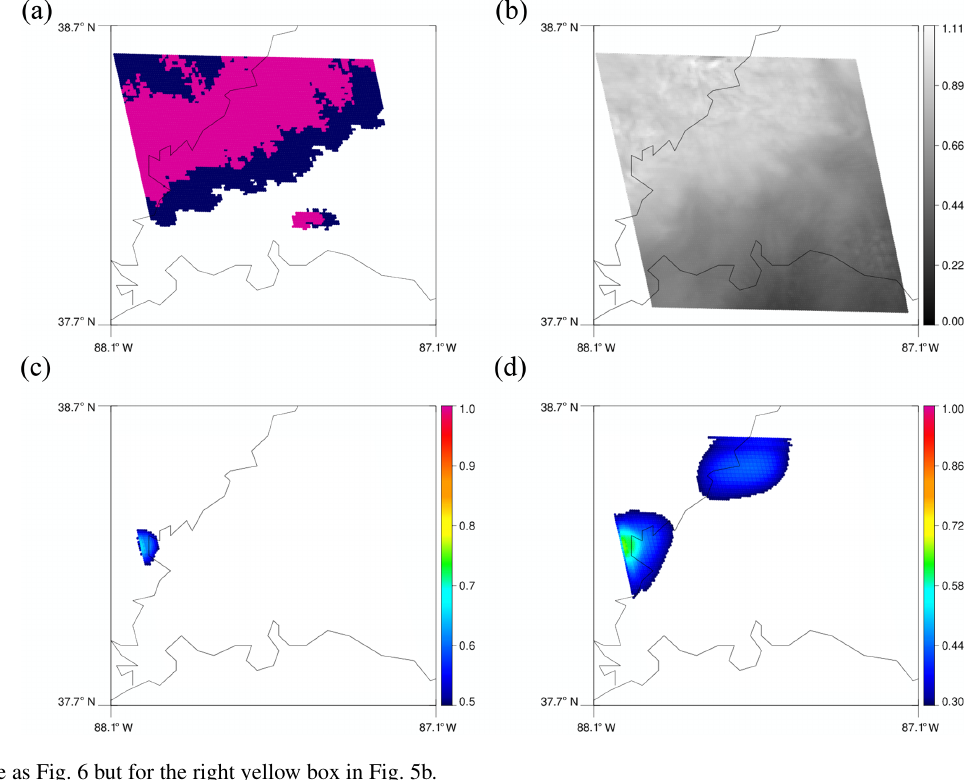
Figure 7. Same as Fig. 6 but for the right yellow box in Fig. 5b.